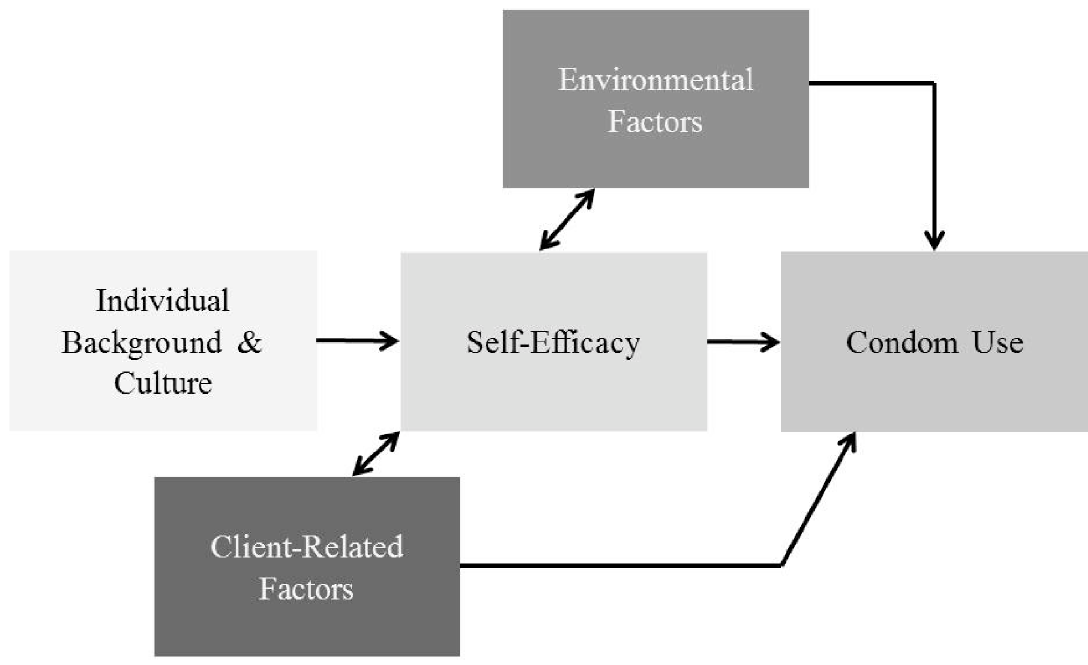
Fig 1. Theoretical map of factors influencing condom use among street-based sex